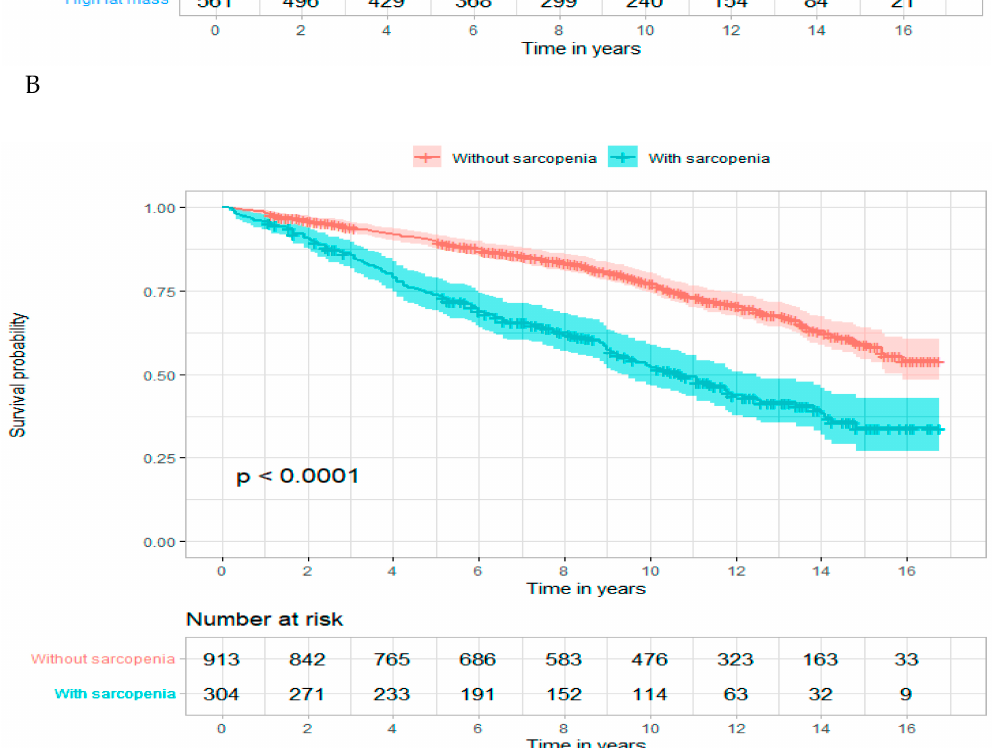
Figure 2. ( A ). Kaplan–Meier curve for total fat mass and all-cause mortality; ( B ). Kaplan–Meier curve for sarcopenia and all-cause mortality.